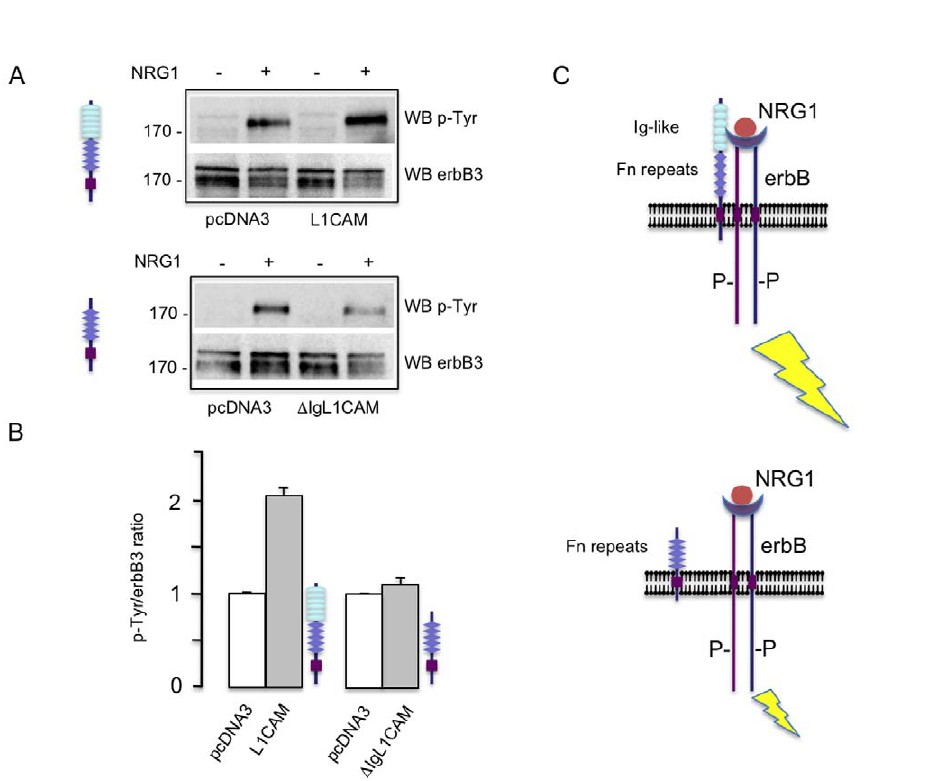
Figure 4. L1CAM-erbB interaction enhances neuregulin induced phosphorylation of erbB3. a ) Upper panel: MCF-7 cells were transiently transfected with pcDNA3-L1CAM or pcDNA3 empty vector. 24 h later, cells were serum starved and stimulated with recombinant NRG1 (50 nM) for 15 min. Then, cells were harvested and lysed. Extracts were submitted to SDS-PAGE and blotted with anti-p-Tyr monoclonal antibody or anti-erbB3 polyclonal antibody. This experiment was repeated three times. A representative experiment is shown. Lower panel: the same approach was used in cells transfected with the D Ig-L1CAM truncated construct. This experiment was repeated twice. One of them is shown. b ) Quantification of western blots by densitometry. The normalized amount of phosphorylated 180 kDa band is increased in cells that express the full length but not the truncated D Ig-L1CAM protein, suggesting that the physical interaction of L1CAM and erbB3 is needed for the enhancing effect on neuregulin receptor activation. Bars represent standard errors c ) Proposed model: the interaction with L1CAM sensitizes erbB receptors to the activation by neuregulins. Removing the Ig-like rich region of L1CAM prevents the interaction and avoids receptor sensitization. For simplicity, only cis -interactions are depicted in the